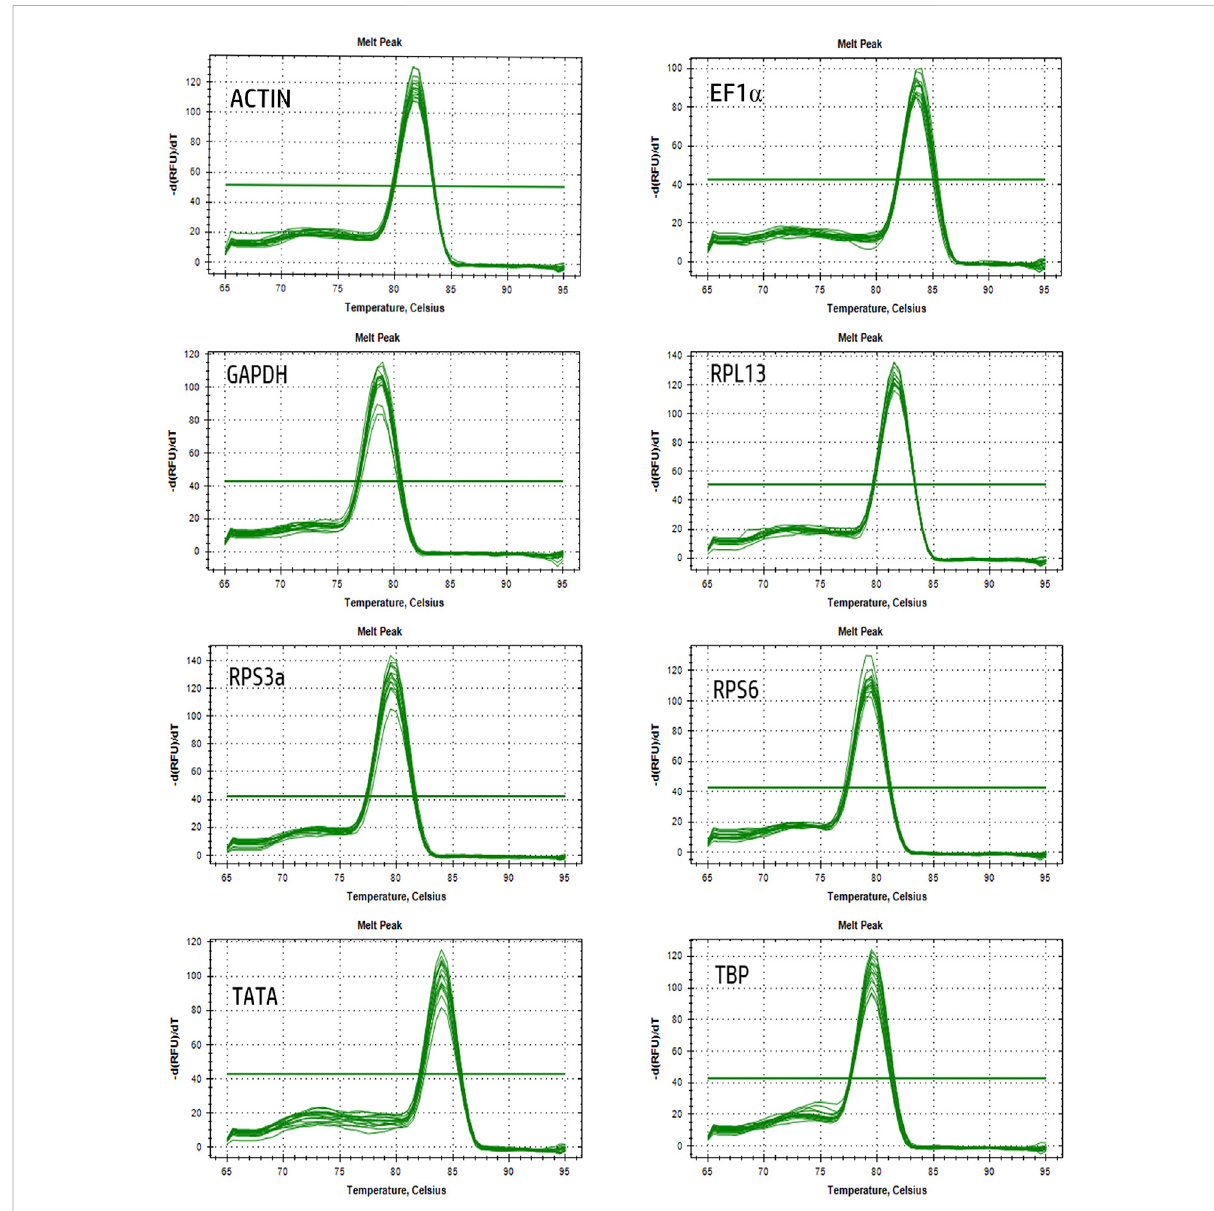
FIGURE 1 Melting curves of the eight candidate reference genes in A. japonicus